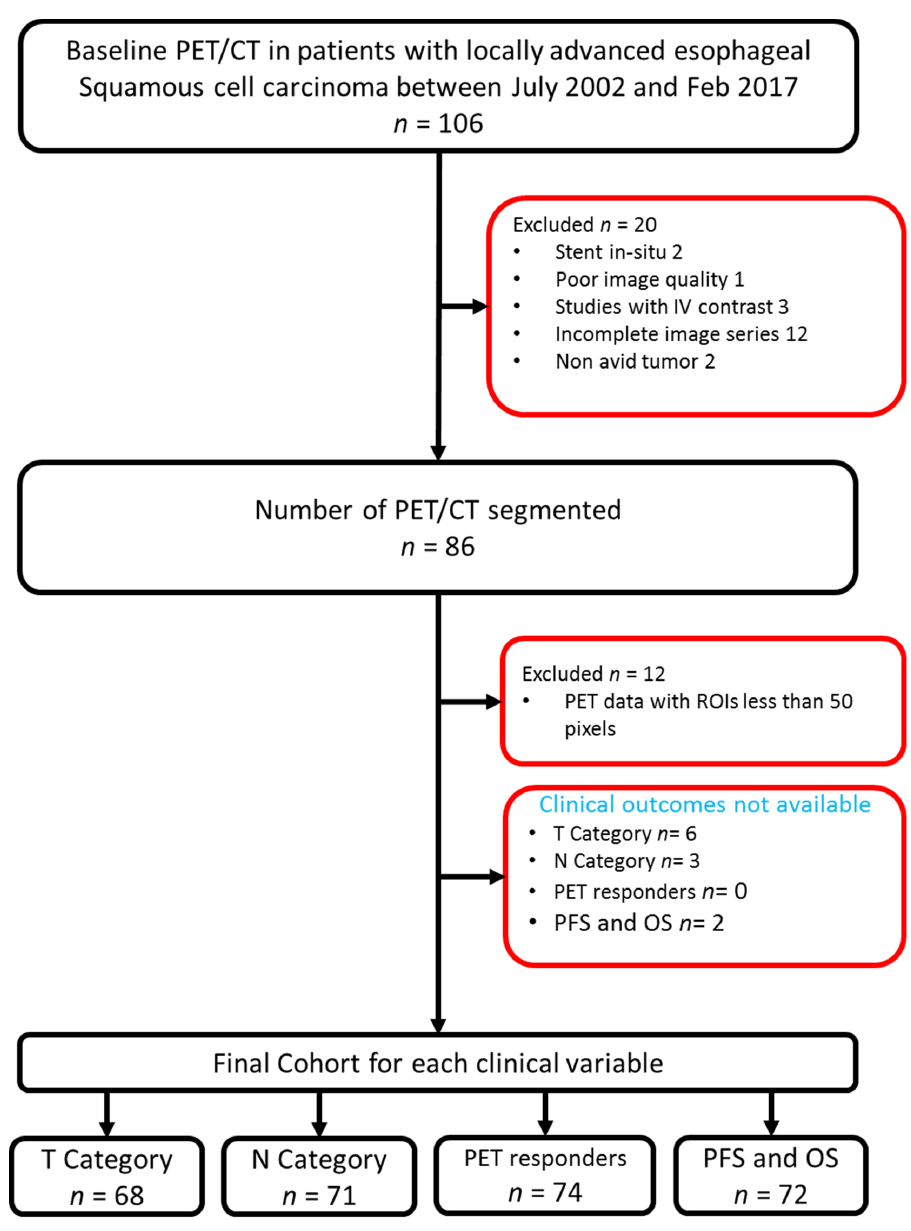
Figure 1. Flowchart of patient inclusion in the study. Abbreviations: T, clinical tumor category; N, clinical nodal category; PFS, progression-free survival; OS, overall survival.